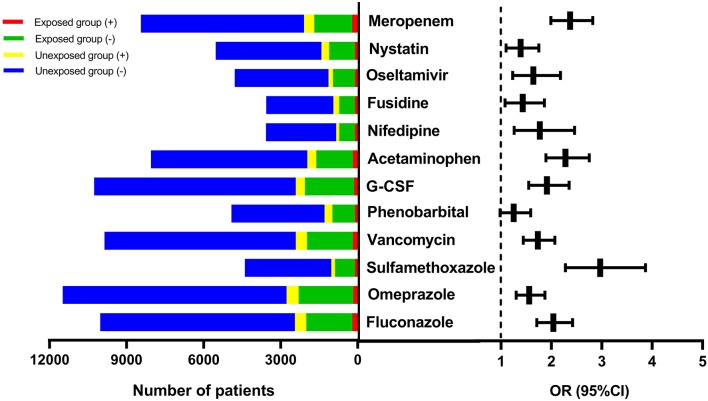
The forest plot for the 12 suspect drugs-DILI associations. DILI, drug-induced liver injury; OR, odds ratio; G-CSF, granulocyte colony-stimulating factor; CI, confidence interval.